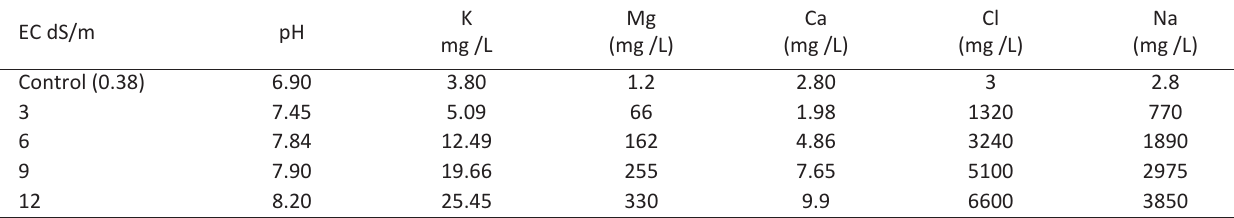
Table 2 ­ The chemical analysis of used water for salt stress treatment EC dS/m